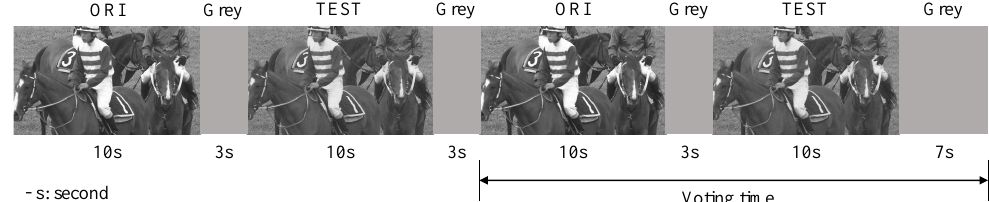
Figure 14. DSCQS method, where the original sequence (ORI) and test sequence (TEST) are pseudo- randomly ordered for each